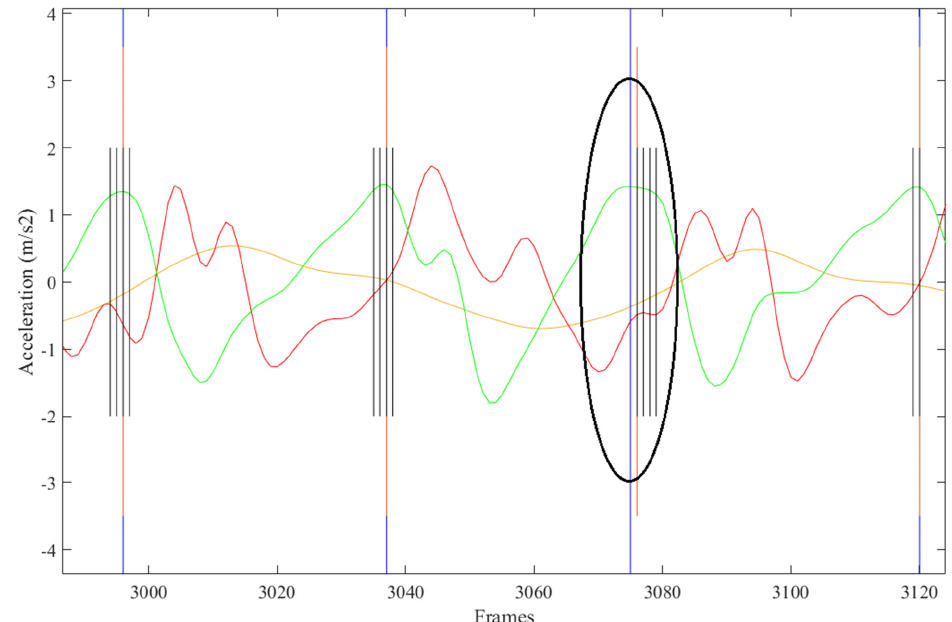
Figure 4. Automated FS (vertical orange line) inserted within five frames of manually labelled FS (vertical blue line).